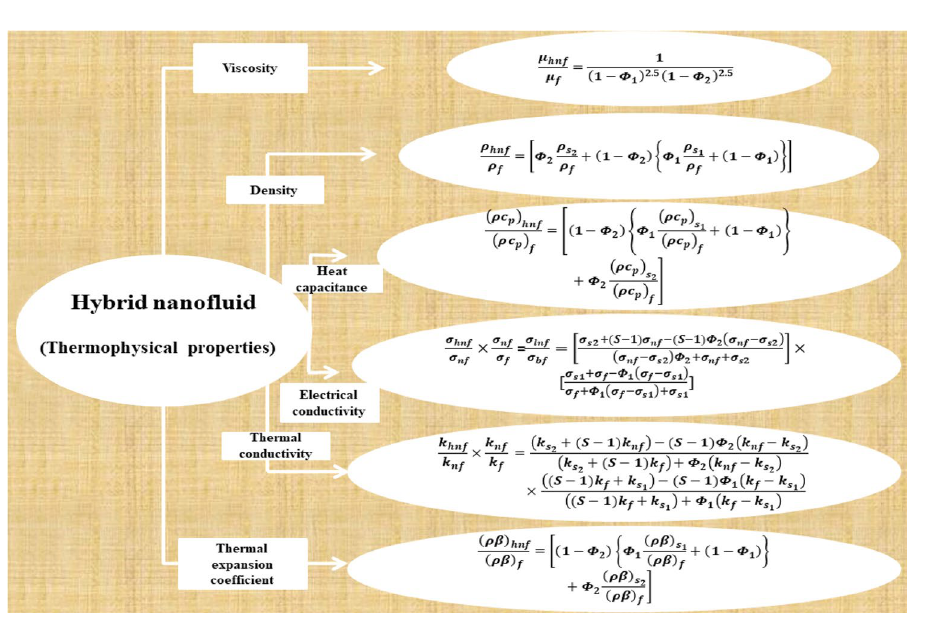
Figure 3. Thermo-physical properties of the